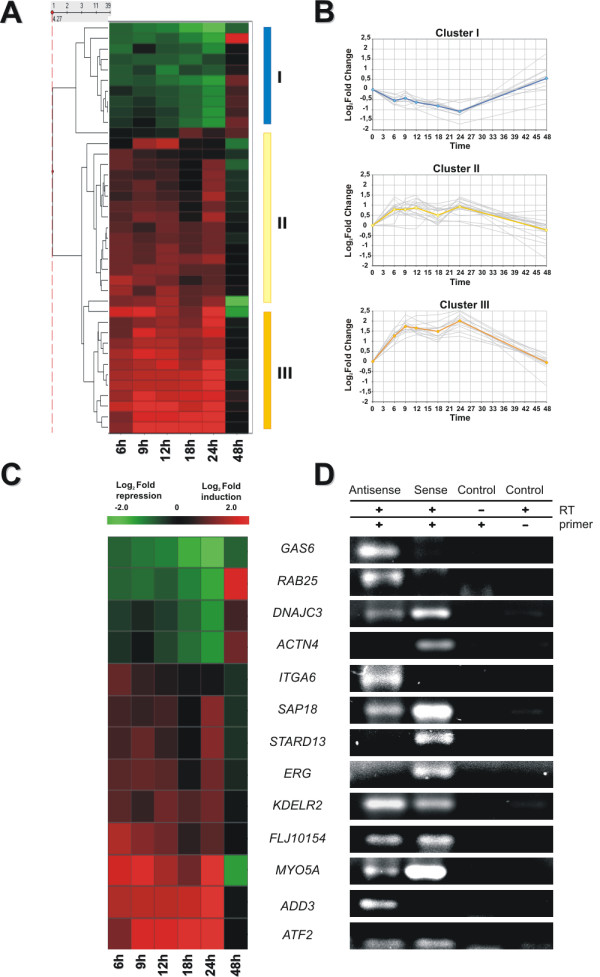
Androgen-responsive intronic RNAs. (A) Hierarchical clustering of 39 intronic transcripts significantly upregulated or downregulated after androgen exposure. (B) Clusters of intronic transcripts (I-III) with similar temporal expression patterns are indicated. Average fold change within each cluster in panel B is indicated by a colored line. (C) Microarray expression pattern of 13 selected androgen-regulated intronic messages selected for orientation-specific reverse-transcription PCR (OSRT-PCR). (D) Transcriptional orientation of 13 selected androgen-regulated intronic messages relative to the correspondent protein-coding mRNA determined by OSRT-PCR. Antisense (GAS6, RAB25, ITGA6 and ADD3), sense (ACTN4, STARD3 and ERG) or simultaneous antisense and sense (DNAJC3, SAP18, KDELR2, FLJ10154, MYO5A and ATF2) transcription (right panel; antisense, sense +RT, + primer) was observed. Controls to monitor the absence of contamination with genomic DNA (right panel; control - RT, + primer) or the absence of RNA self-priming (right panel; control + RT, - primer) are indicated. Names between panels C and D refer to protein-coding RefSeq mRNAs that map to the same loci and define intronic regions where active transcription was detected.